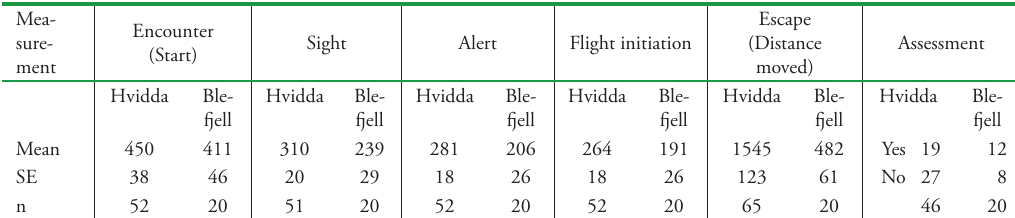
Norway during three periods in 2004-2006. Reference levels for categorical variables are provided in the table (the level after the vs . term, such as “Blefjell” for area, “summer” for season and “level” for terrain).Values for ln encounter distance were centered around the mean.